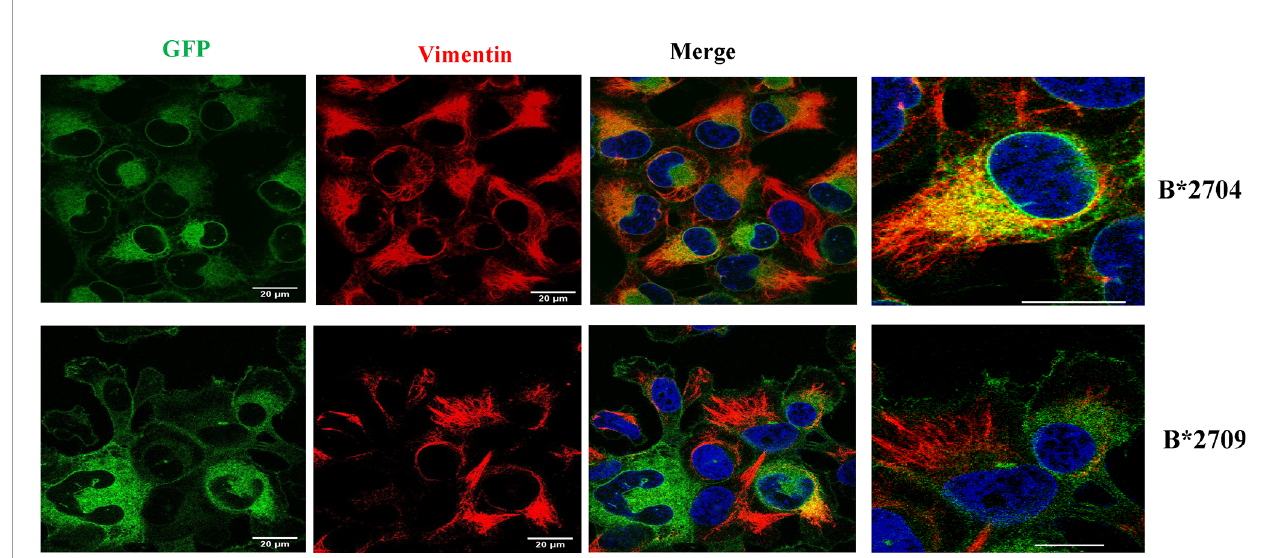
FIGURE 6 | Representative confocal microscopy images of cells transfected with GFP-fusion (green) constructs of B*2704 and B*2709 subtypes, using anti- vimentin antibody (probed with anti-mouse Alexa Fluor 594; red). Nuclei were stained with DAPI (blue). Merged images of GFP with vimentin, as well as vimentin with DAPI, are also shown. Scale bar, 20 m m. Images shown on the right are enlarged views of a section of the merged image. GFP, green fl uorescent